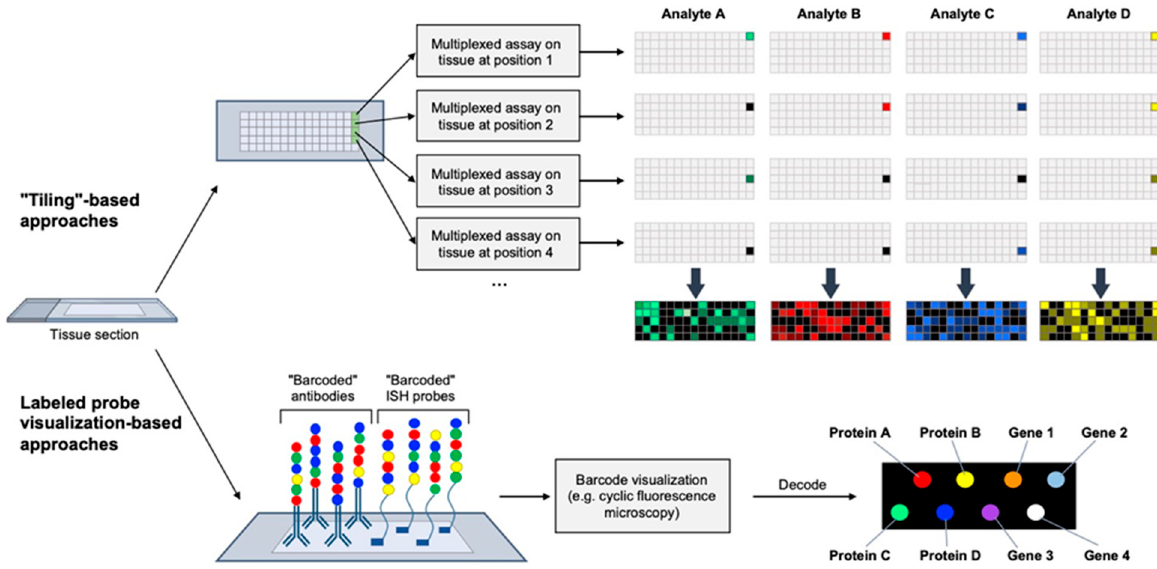
Figure 2. Overview of spatial genomics, transcriptomics, and proteomics methodologies. Tissue sections are typically visualized either through a “tiling”-based approach or through the visualization of “barcoded” probes.